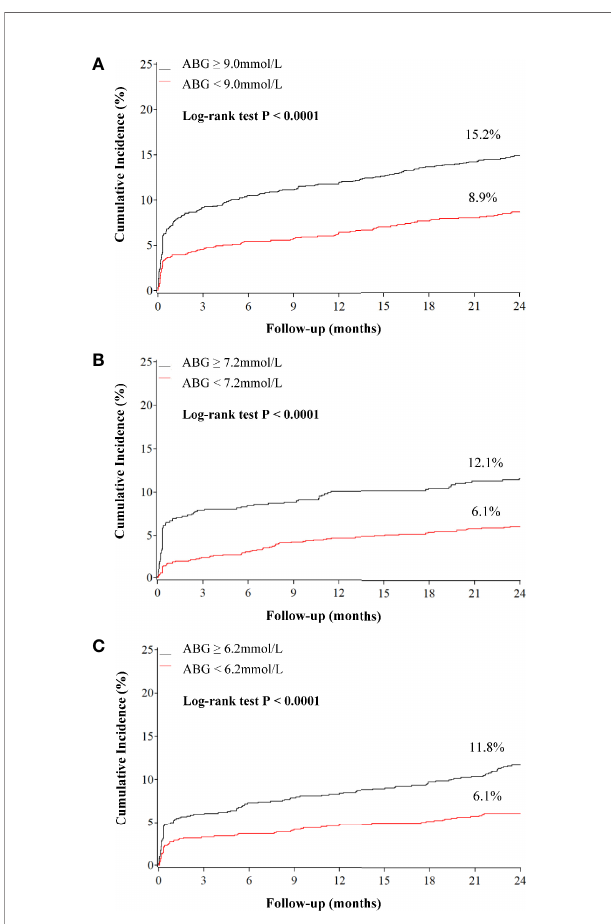
FIGURE 2 | Kaplan – Meier curves for all-cause mortality according to admission blood glucose levels in patients with different glucose metabolism status. (A) diabetes; (B) pre-diabetes; (C) normal glucose regulation. ABG, admission blood